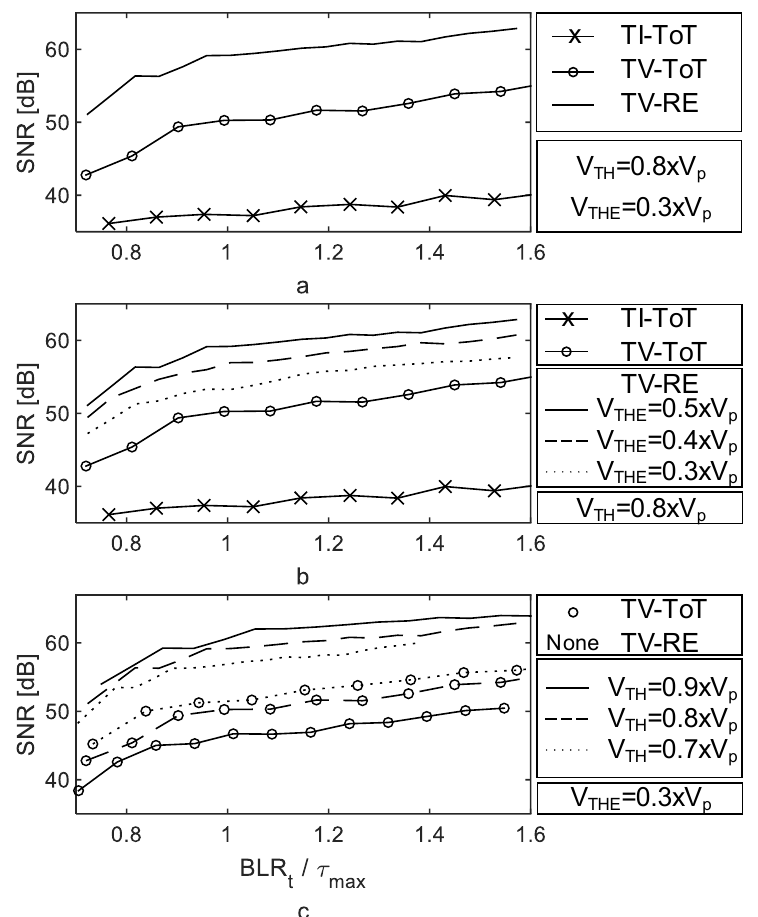
Figure 9. SNR of ToT-PW and RE-PW versus BLR t for TI-ToT, TV-ToT and RE techniques for optimizing V TH and V THE